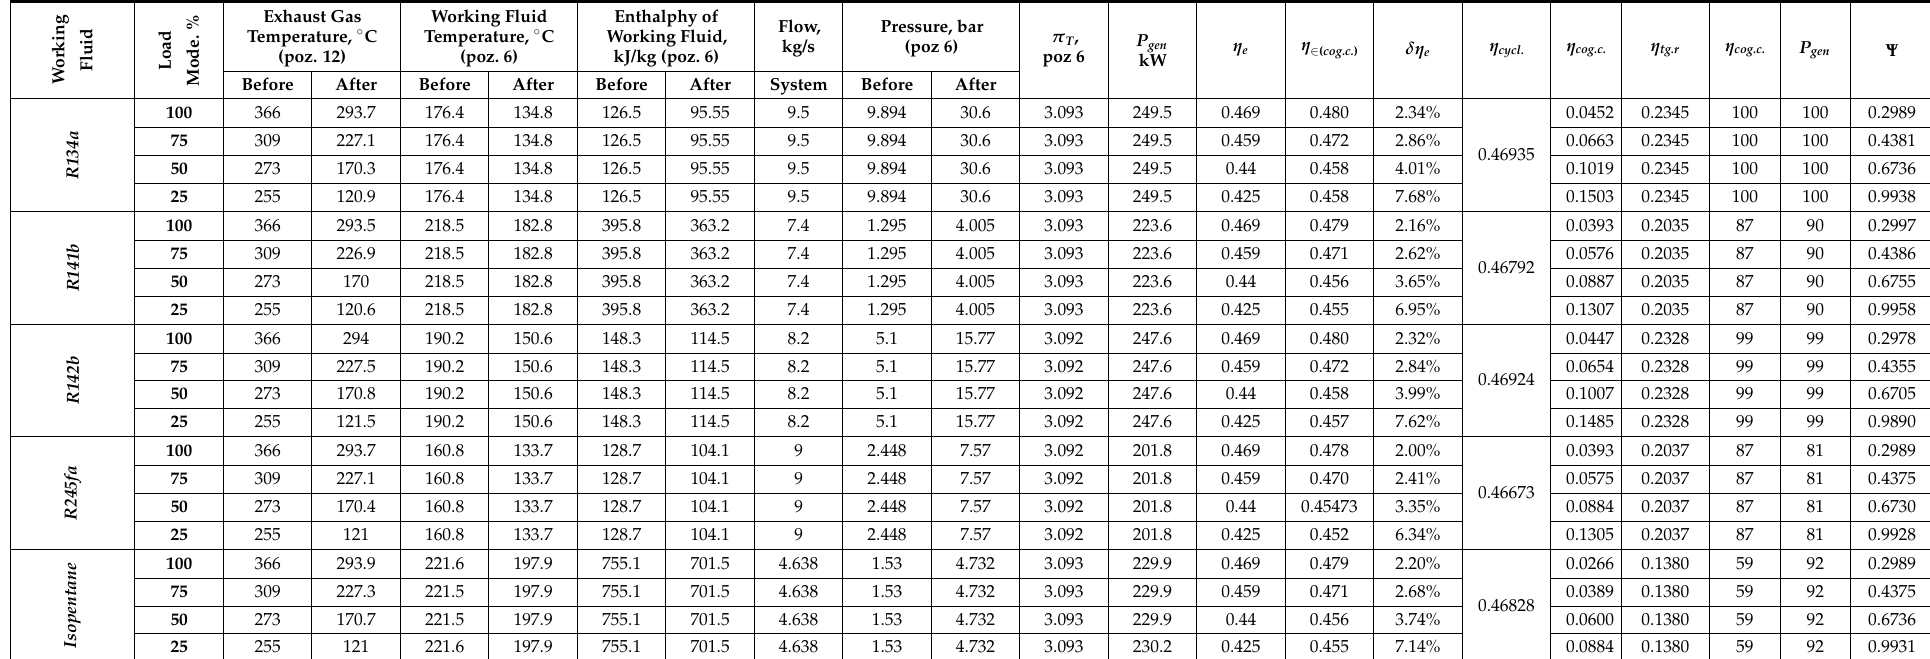
Table 4. Results of cycle simulation: strategy G w.fl. = const